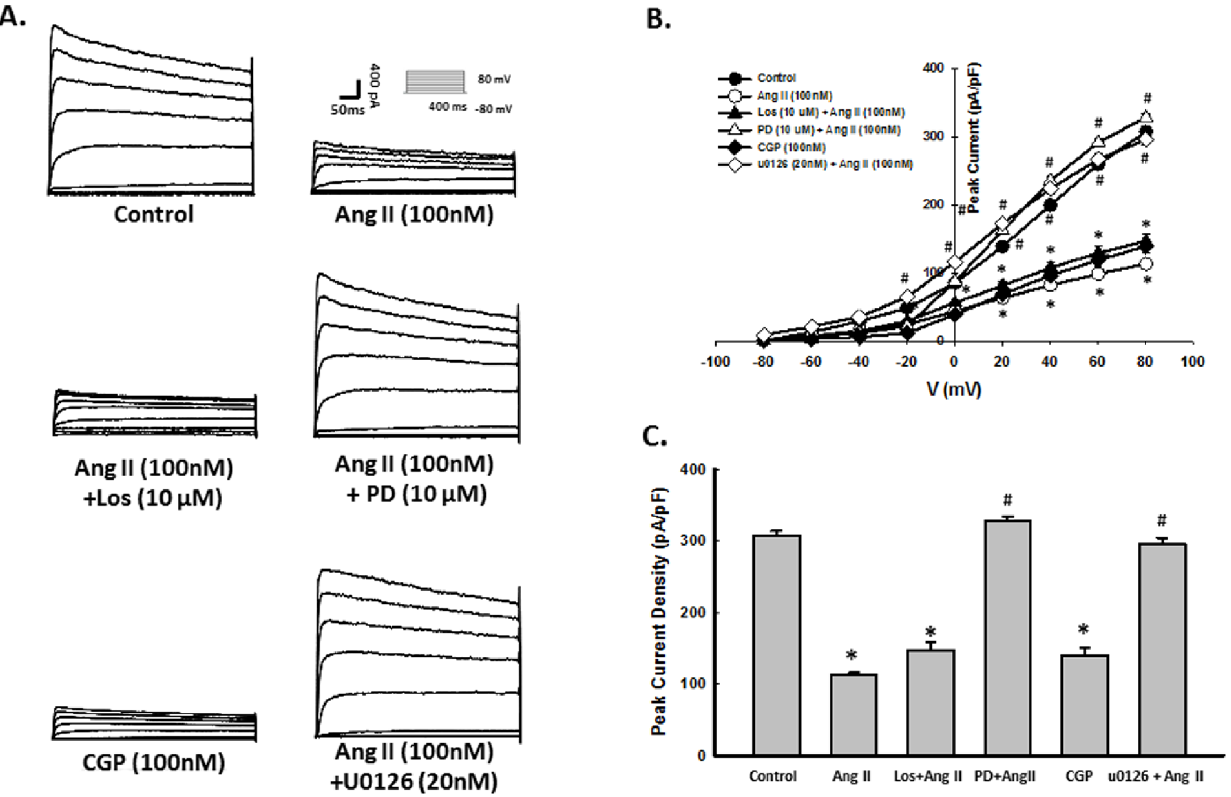
Figure 5. Ang II-mediated blockage of K + currents lies downstream of AT2R/ERK pathway. A) Representative K + current traces showing response of Ang II, Ang II + PD123319, Ang II + Losartan, CGP42112A or Ang II + U0126 in NSCs evoked from 2 80 to 80 mV. NSCs were pre-treated with vehicle, Losartan, PD123319, or U0126 for 1 hour followed by incubation with Ang II or CGP42112A for 24 hours. B) Mean data of peak K + current change from 2 80 to 80 mV. C) Peak K + current change at + 80 mV. *P , 0.05 vs untreated control group, # P , 0.05 vs Ang II- treated group; n=10 in each group.